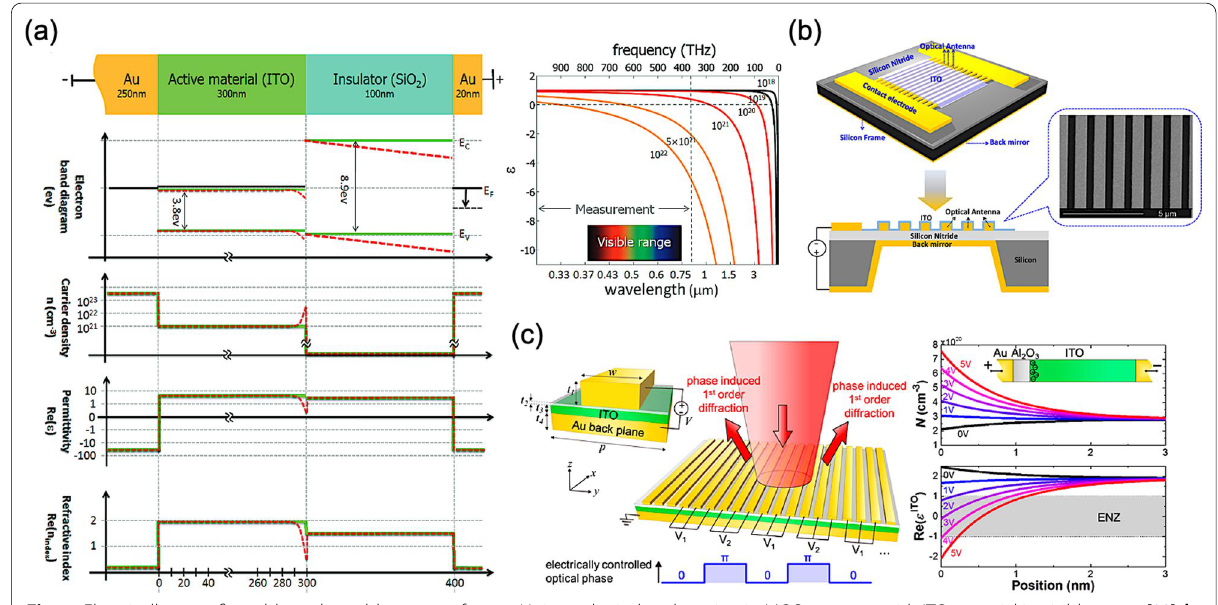
Fig. 7 Electrically reconfigurable and tunable metasurfaces a Unity‑order index changing in MOS structure with ITO material in visible range [98], b Voltage‑tuning metasurface absorber with plasmonic nanostrip antennas [99], and c Gate‑tunable metasurface with dynamic phase grating